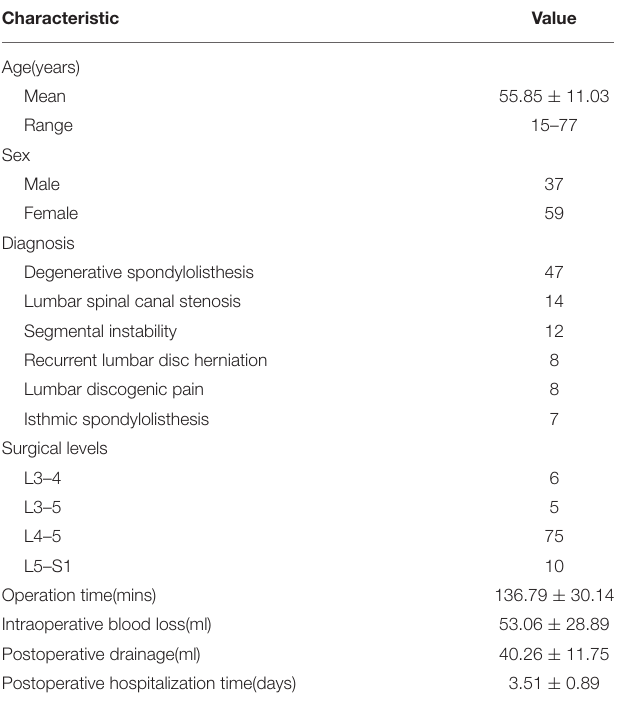
TABLE 1 | Basic demographic and surgical characteristics.